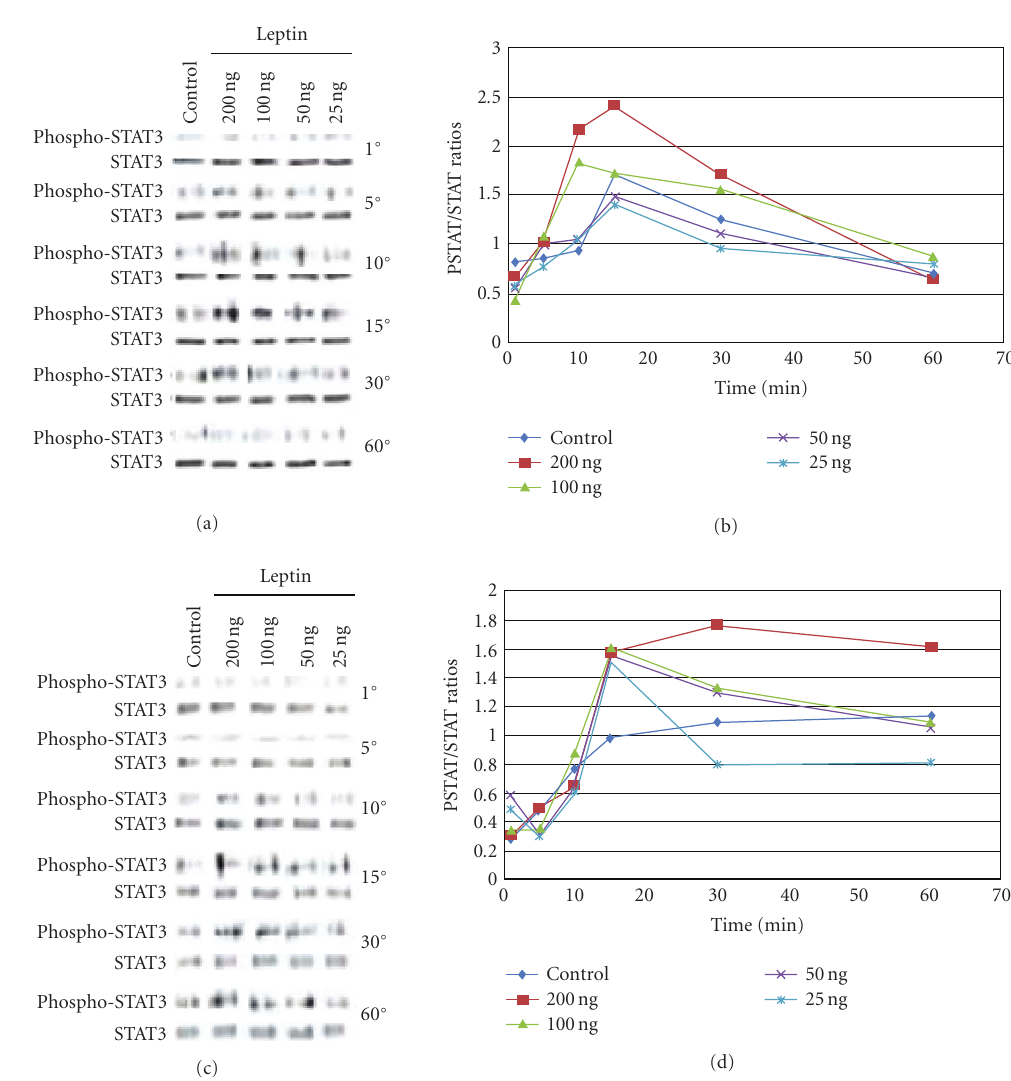
Figure 4: Leptin stimulates early phosphorylation of STAT-3 in PC-3 cells. PC-3cells (a) or LNCaP cells (c), devoid of growth factors by an overnight exposure to basal medium, were exposed to increasing concentrations of leptin for various time points. 25 μ g of the cell lysates obtained after each time point were separated on a 7.5% SDS-PAGE and Western-blotted, and the phosphorylated STAT-3 proteins were revealed by incubating with phospho-STAT-3 antibody followed by chemiluminescent detection. The membranes were stripped and reprobed with STAT-3 antibodies to verify the protein levels. In (b) and (d), densitometric analysis of phospho-STAT-3 and STAT levels was determined. A time-course, dose-response curves of phosphor-STAT-3/STAT-3 (PSTAT/STAT) ratios for the e ff ect of increasing leptin concentrations are depicted for both (b) PC3 and (d) LNCaP. The original western blots are shown in (a) and (c). Results shown are representative of three separate